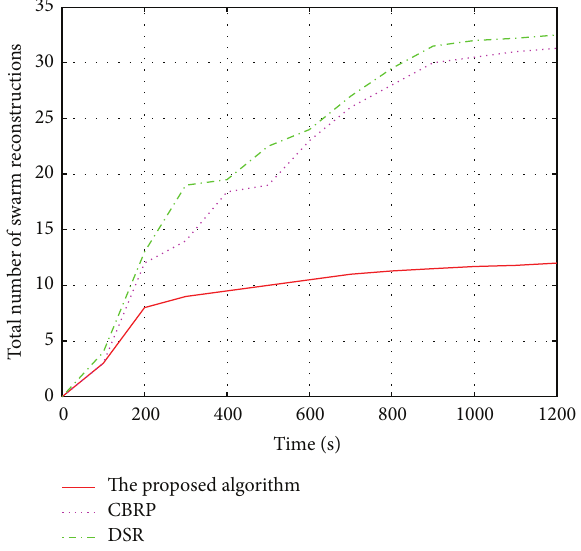
Figure 8: The proposed algorithm, CBRP, and DSR number of sent packets versus end-to-end delay for 15